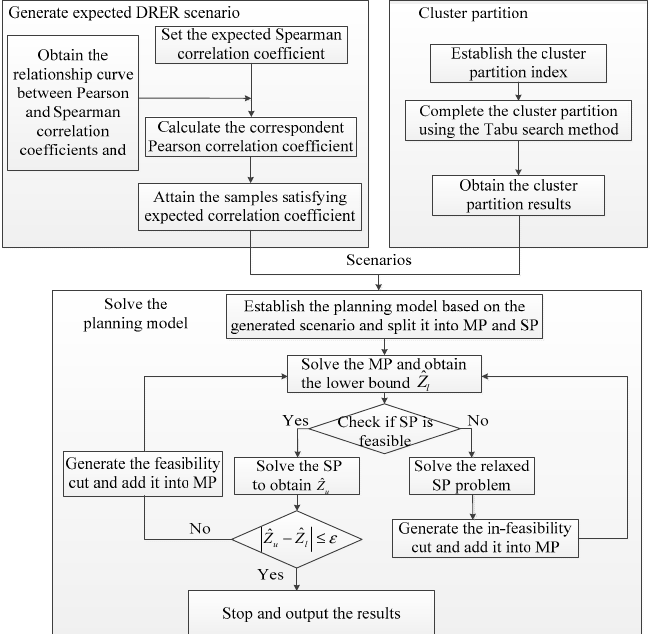
Figure 3. Calculation process of the proposed method.